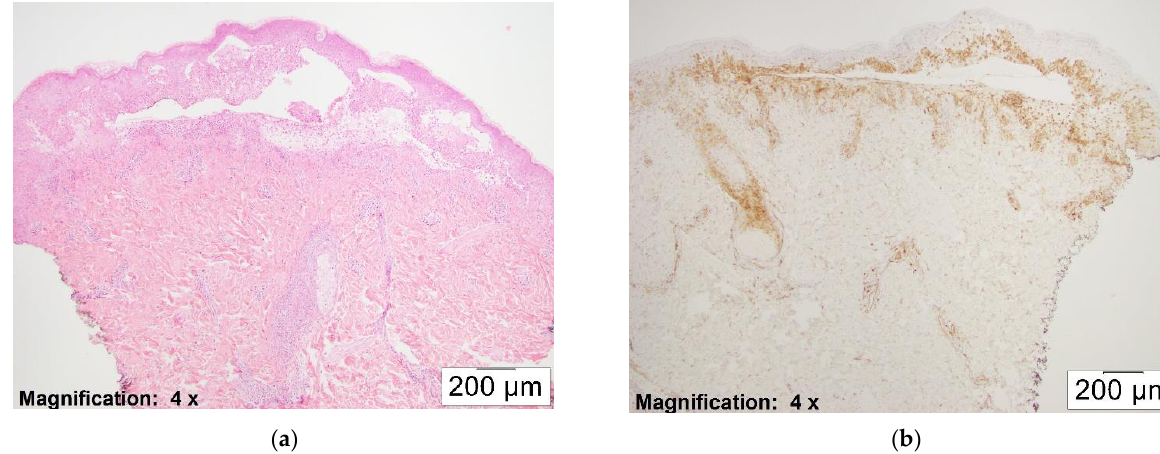
Figure 3. ( a ) H&E, ×4. This figure shows actively blistering mycoplasma pneumonia induced EM. ( b ) CD123, ×4. This figure shows dense inflammatory infiltrate with pDCs in the same case (3+ staining pattern). At the same time, partially or fully re-epithelialized older lesions with less lympho- cytic inflammation revealed minimal staining with CD123 (see Figure